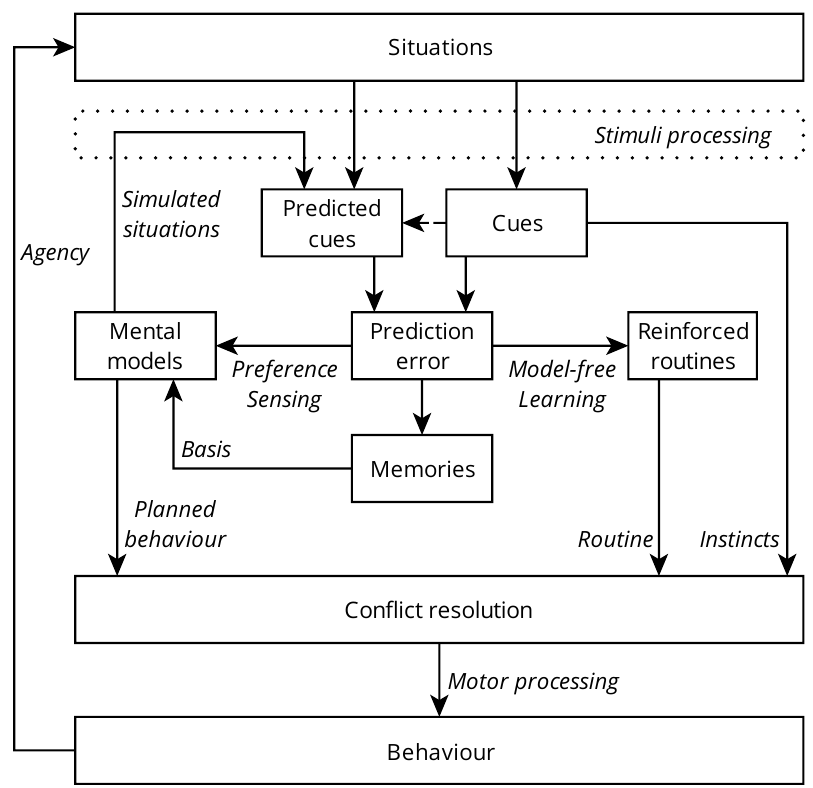
Figure 1. The Adaptive Motivation Model. Arrows represent influence.